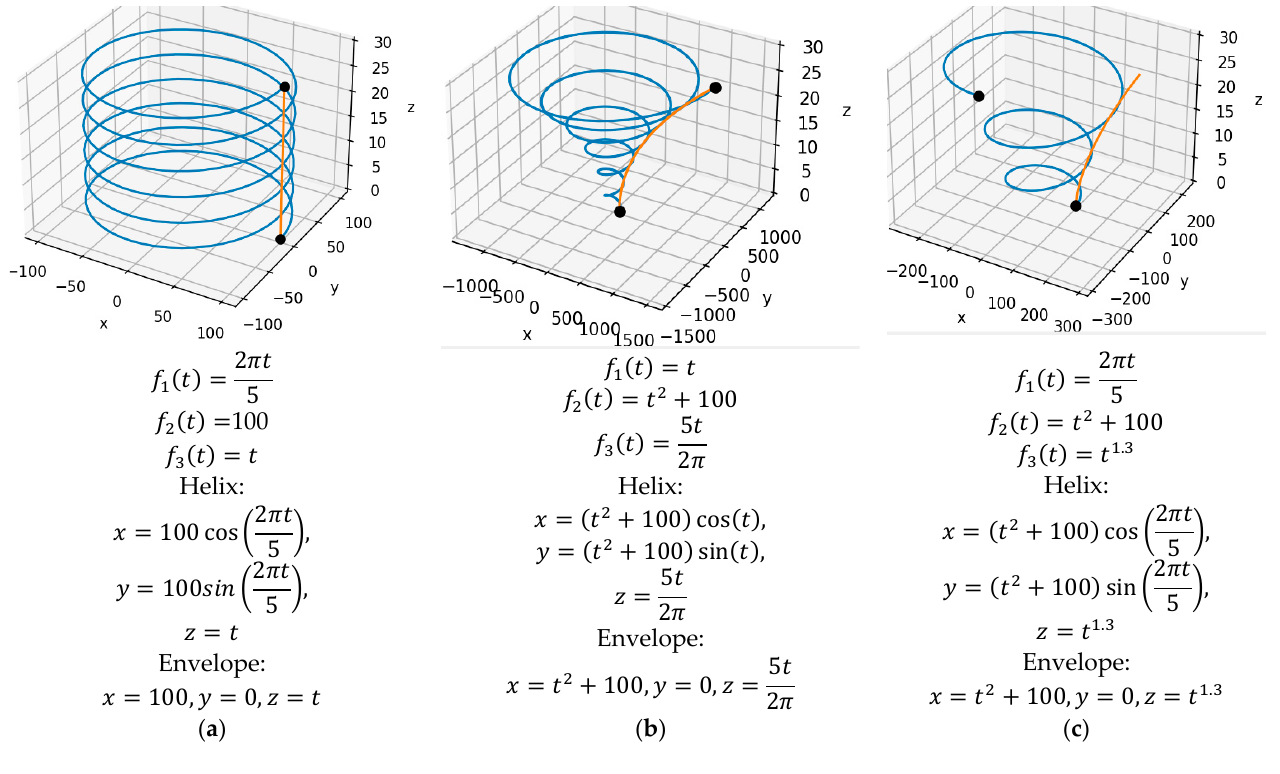
Figure 7. Helixes (blue color) and their planar envelope curves (red color): cylindrical ( a ); parabolic ( b ); parabolic with variable pitch ( c ).